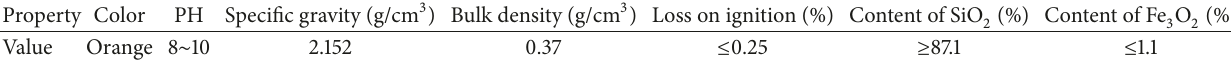
Table 6: Properties of diatomite.